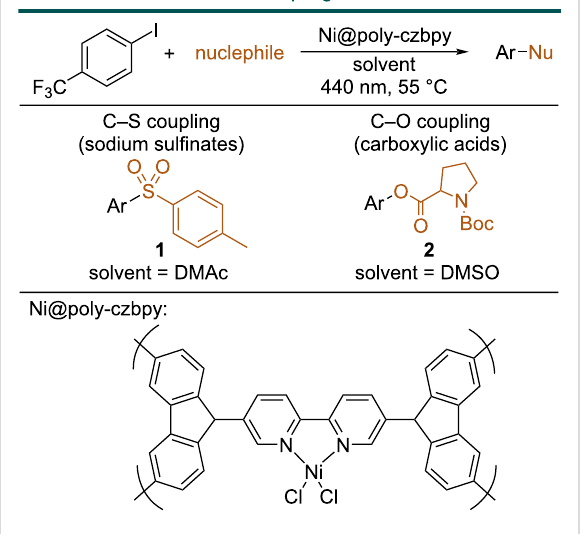
Figure 3: Flow diagram of the experimental setup loaded in an injec- tion loop with the reaction mixture. Once homogeneous conditions were achieved, the reaction mix- ture was injected into the reactor, which was radiated with 440 nm LEDs at 55 °C. A poor yield (16%) was obtained using a residence time of 3 hours. This result called for a more detailed investigation of crucial reaction parameters to under- stand if the limitation is of catalytic or technological